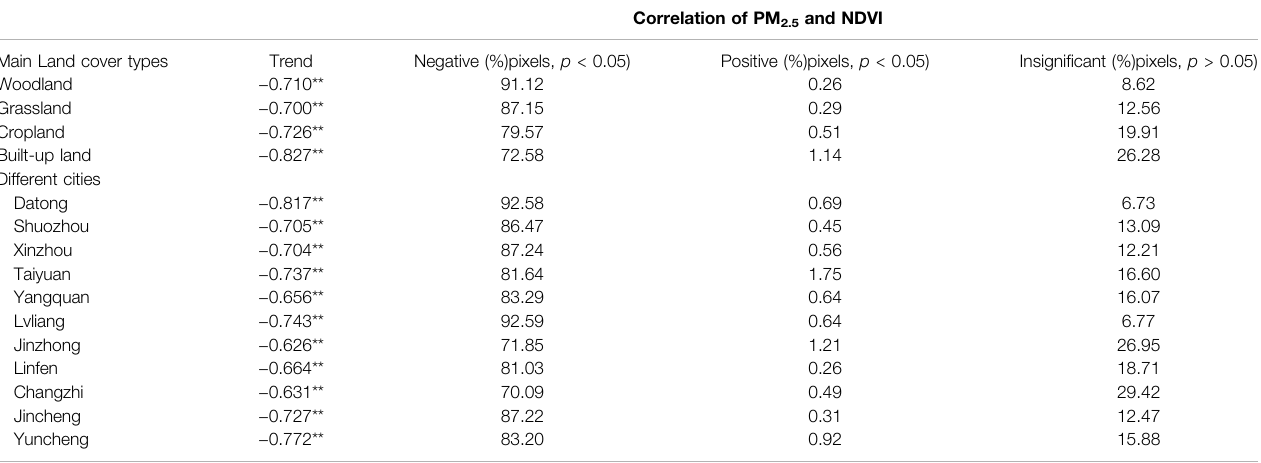
TABLE 3 | Correlations between NDVI and PM 2.5 in different land cover types and cities.